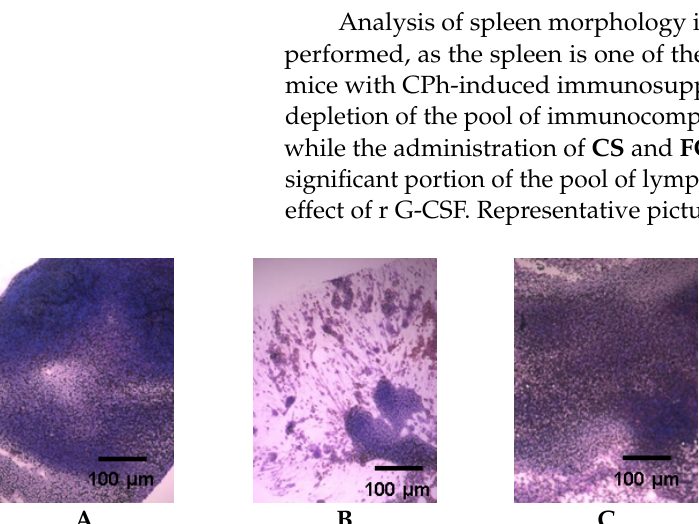
Figure 5. Spleen fingerprints of mice with CPh-induced immunosuppression after treatment with tested compounds (hematoxylin–eosin staining). ( A ) Control, ( B ) CPh, ( C ) CPh-r G-CSF, ( D ) CPh- CS , ( E ) CPh- FCS . Original magnification ×400.